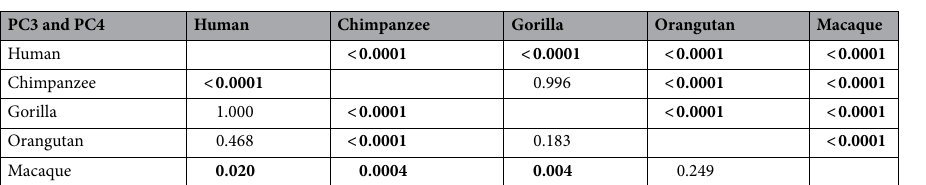
Table 3. P -value of post-hoc tests for multiple comparisons in whole-sample analysis for PC3 and PC4. The right-upper cells represent the P -value for PC3 and the left-lower cells represent PC4. P -values < 0.05 are in bold for PC3 and PC4 to indicate significant